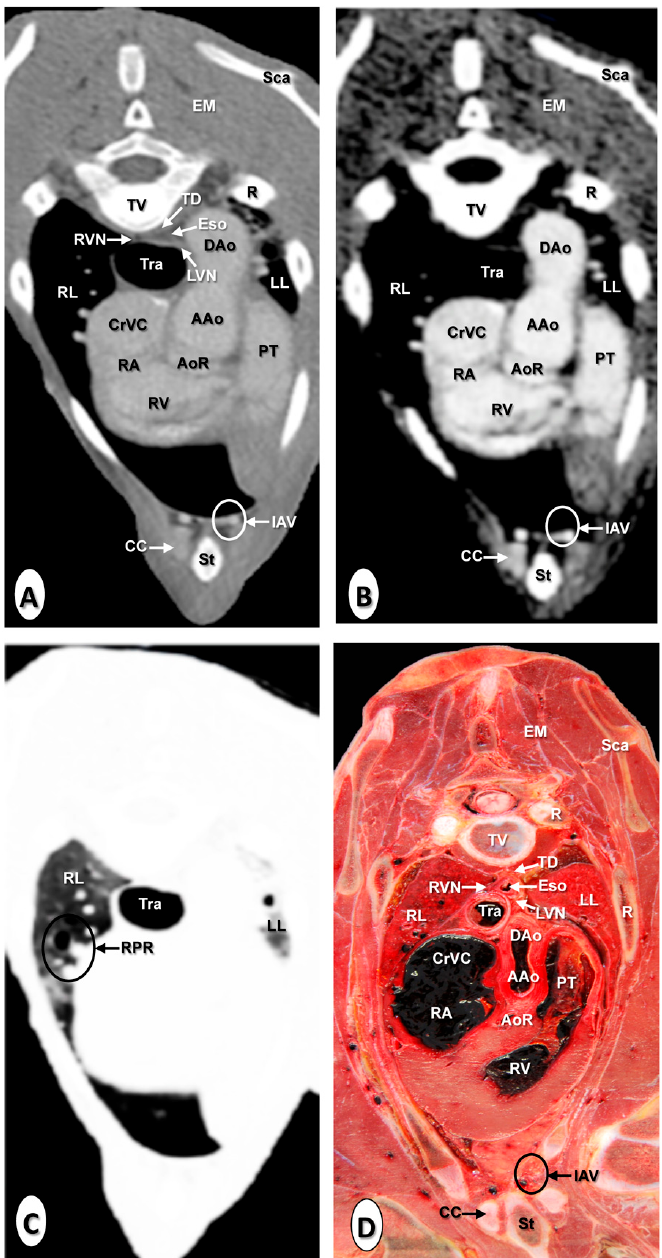
(Eso); internal thoracic artery and vein (IAV); left lung (LL); left pulmonary root (LPR); left vagus nerve (LVN); rib: Costal bone (R); rib: Costal cartilage (CC); right lung (RL); right pulmonary root (RPR); right vagus nerve (RVN); scapula (Sca); sternum (St); thoracic duct (TD); thoracic vertebra (TV); and trachea (Tra).